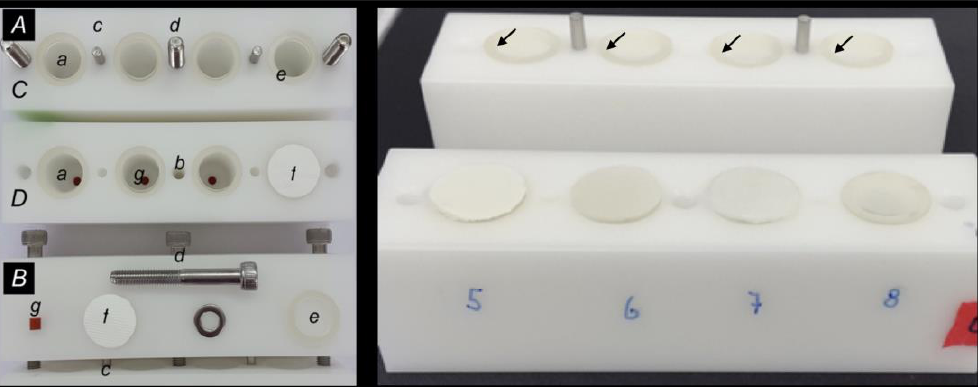
Figure 2. Left : Disconnected two-chamber system model: View from above (( A ) with the upper ( C ) and lower component ( D )) and the side (( B ) upper part). The models had four chambers each (a). Holes (b) were drilled in the blocks, which allowed for firm connection and anchorage using metal guidance pins (c) and fixation screws (d). Rubber rings (e) were used to seal the individual chambers between the upper and lower blocks. The membranes on carriers (f) were placed between the blocks and rubber rings, respectively. Rubber plugs (g) at the top and bottom closed the chambers. Right : Test membranes and foil in situ. Rubber rings placed on the upper block (arrows) to ensure a tight seal and fixation of the membranes.